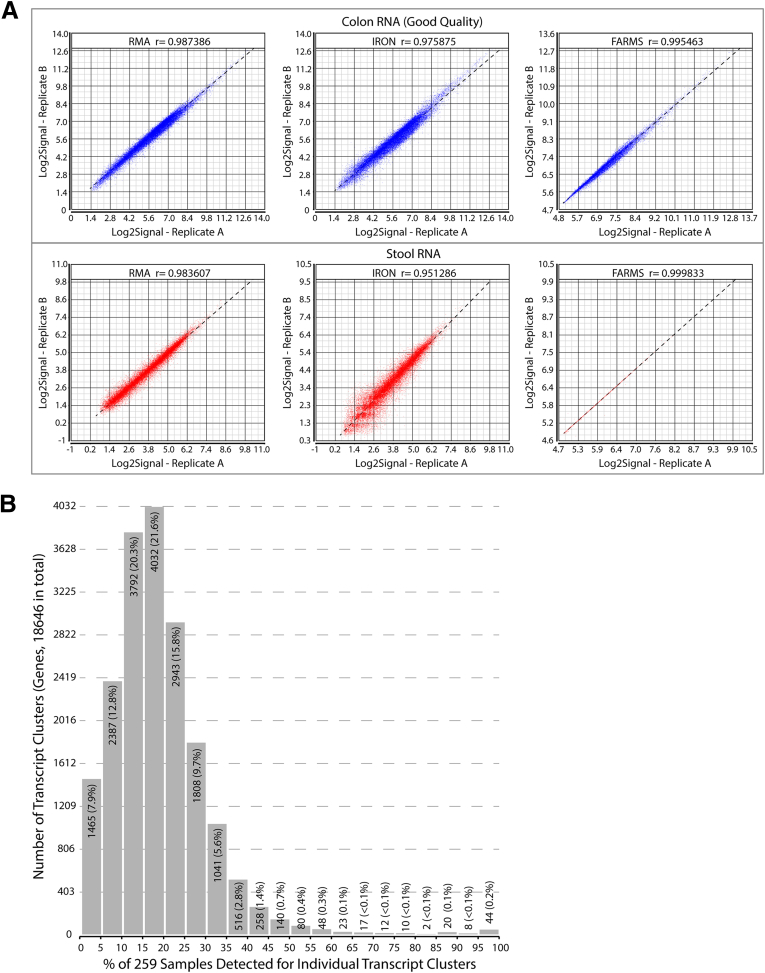
Reproducibility and detectability of the microarray data using human fecal samples. (A) Scatter plots of technical replicates showing high reproducibility of the microarray data generated using fecal RNAs. These data were quite comparable with that generated using high-quality colon RNA (colon tissue RNAs were adopted from Affymetrix publicly available Sample Data). Note that the FARMS summarized data appears to show a substantial level of compression. Conversely, a somewhat higher degree of variation was noted within the IRON normalized data. (B) Histogram of signal detection level showing that microarray technology is reliable in the detection of low copy numbers of fecal RNAs. We calculated the detection of transcript clusters (genes) based on the P values reported at probe-set level for intensity data (there were no P values reported for the transcript cluster level of intensity data). At first, the total number of detected multiple probe-sets for a given transcript cluster was counted across the entire 259 chips at P < .05, then this number was divided by the total number of multiple probe-sets on a chip for this given transcript cluster. Approximately 80% of the 18,646 known genes were detectable in at least 10% of 259 samples.